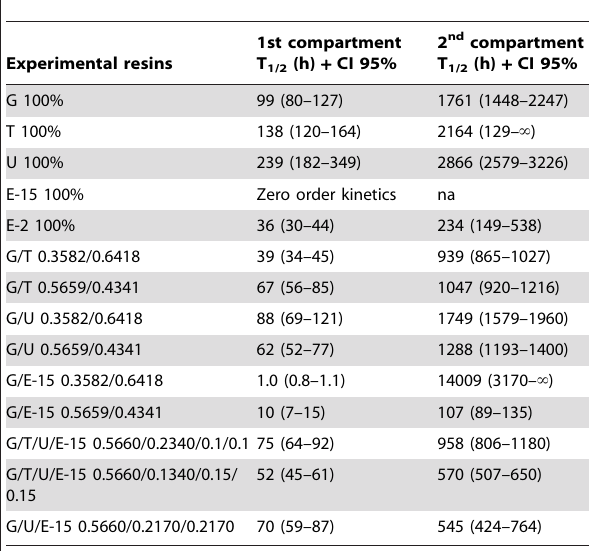
Table 6. Decay kinetics parameters for experimental compositions using a bi-exponential model.